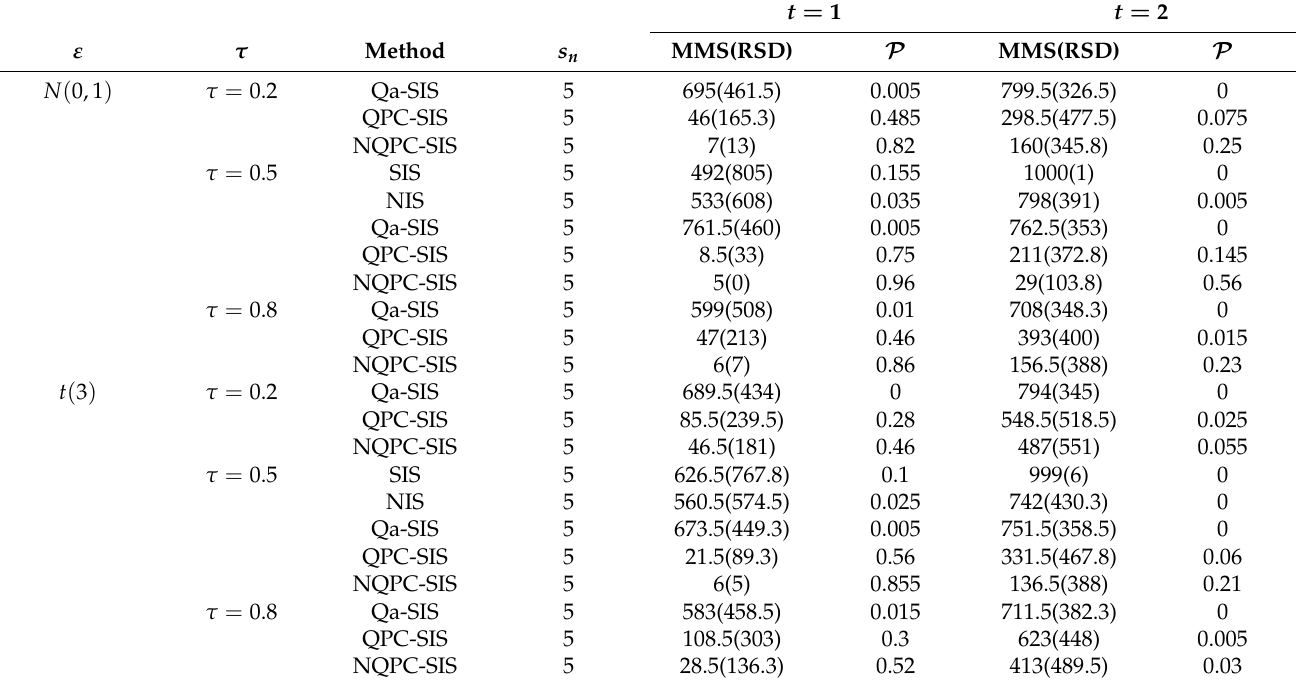
Table 3. Simulation results for Example 3 when n = 200.